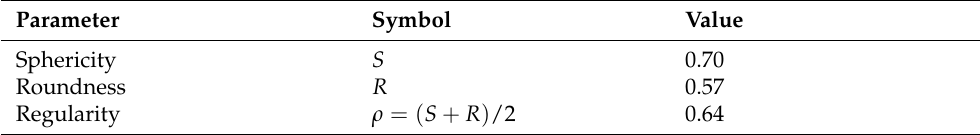
Table 3. Particle shape parameters.